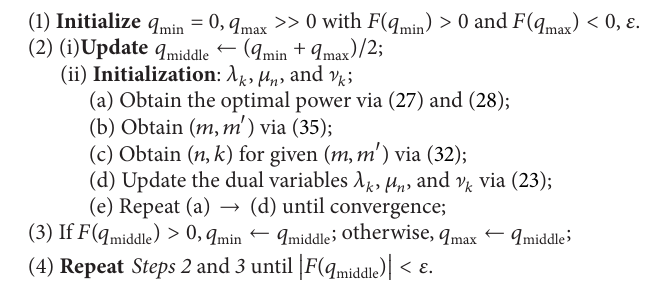
Algorithm 1: Bisection-based energy-efficient resource allocation